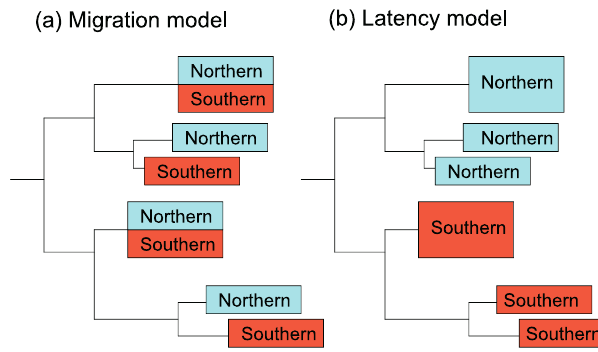
Figure 1. Models for the Global Evolution of Influenza Virus Two phylogenetic hypotheses depicting the evolution of A/H3N2 influenza virus by (A) global migration, in which isolates from adjacent seasons in the northern and southern hemispheres are interspersed topologically, or by (B) reactivation of latent virus, in which isolates from the northern hemisphere give rise, in situ, to isolates that circulate in the same locality the next season, and thus are topologically linked (likewise for southern hemisphere viruses).